Question: What does this figure show? Answer in one sentence.
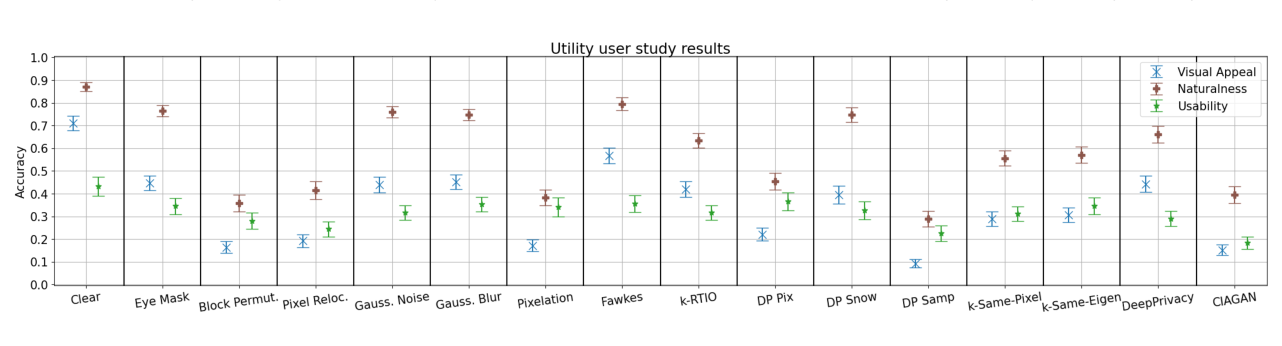
Answer: User study agreement scores for our three statements (visual appeal, naturalness and usability) for clear and all anonymizations.